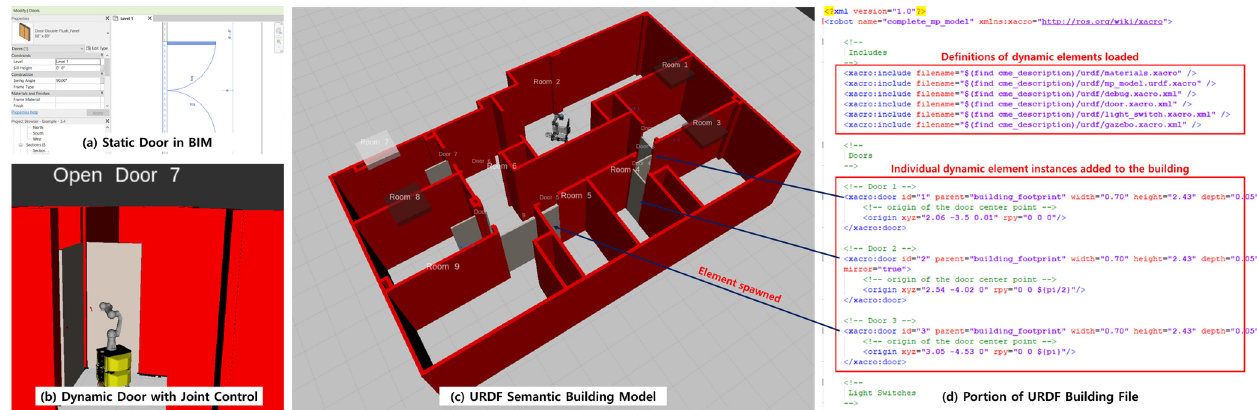
Figure 3. URDF building model creation for semantic localization of ( a ) conventional static door element in BIM, ( b ) dynamic door element with joint control, ( c ) 3D URDF building model with static and dynamic building elements, and ( d ) part of the URDF building file presenting dynamic building elements.